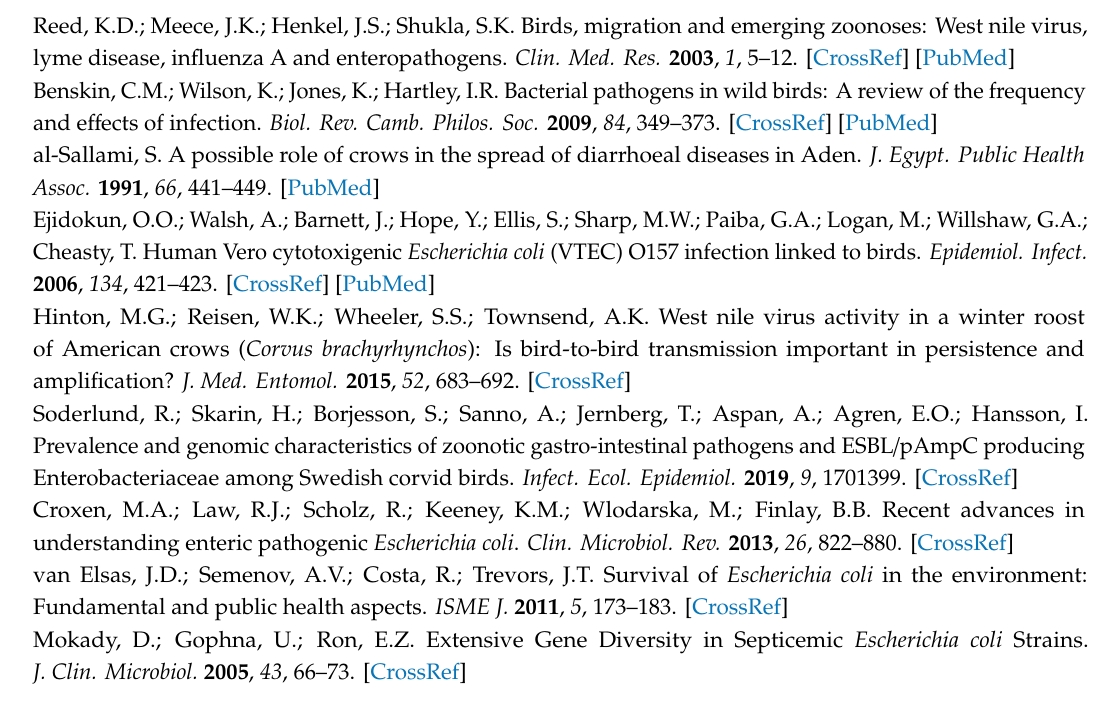
Figure S1: PCR products of quadruplex performed with primers for iroN, hlyA, OmpT and iss on water and fecal (F) isolates. Samples were run on 2 % gel. Figure S2. Percentage of fecal E. coli isolates from non-wetland ( n = 34) and wetland ( n = 71), showing antimicrobial resistance to 13 selected antimicrobials. Figure S3: PCR products for bla-CMY-2, 454 bp (A) or bla-ctx-M, 554 bp (B), obtained from donor (D) ExPEC / APEC strains and corresponding trans-conjugants(Tc) following mating with E. coli